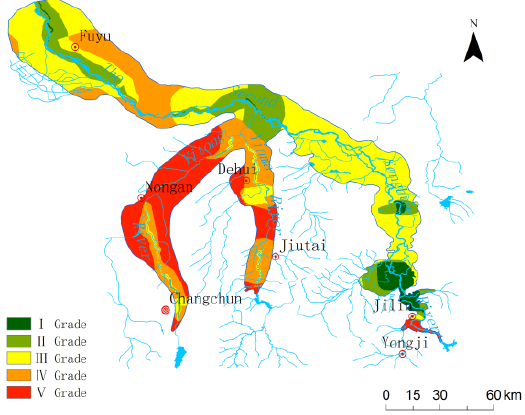
Figure 19. Suitability of interaction intensity between surface water and groundwater.